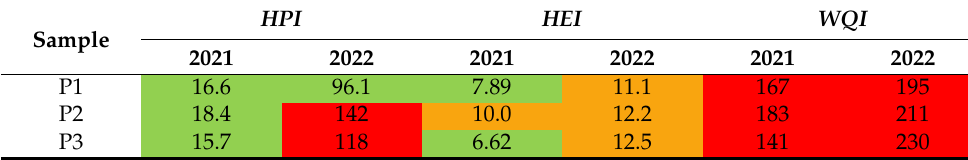
Table 5. The heavy metals pollution assessment through pollution indices.